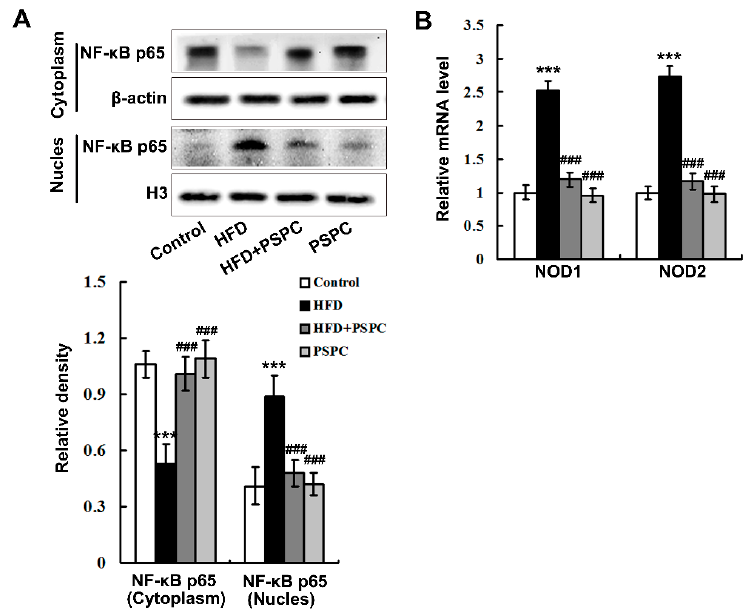
Figure 5. PSPC abates NF- κ B p65 nuclear translocation and NOD expression in HFD-treated mouse livers ( n = 3). ( A ) Immunoblotting and densitometry analysis of nuclear and cytoplasmic NF- κ B p65 in mouse livers; ( B ) the mRNA levels of Nod1 and Nod2 in mouse livers. All of the values are expressed as the mean ± SD. *** p < 0.001 vs. the control group; ### p < 0.001 vs. the HFD group.